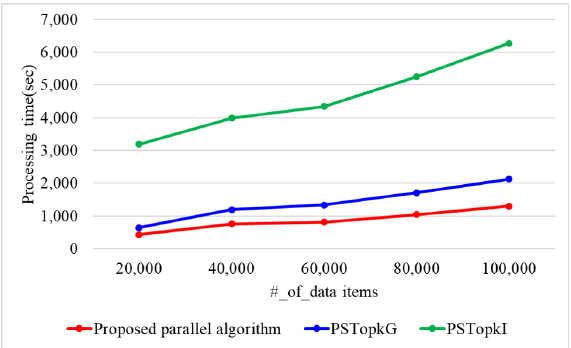
Figure 13. Processing time with a varying number of data items in 10